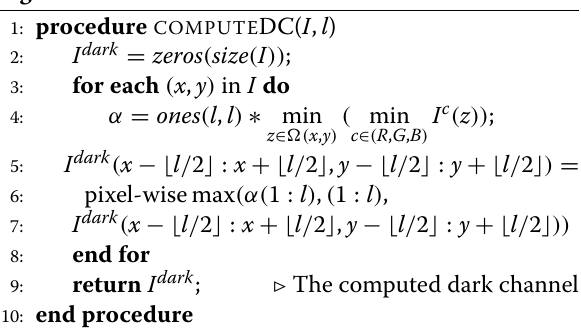
Algorithm 1 Modified dark channel Algorithm 2 Dehazing method proposed